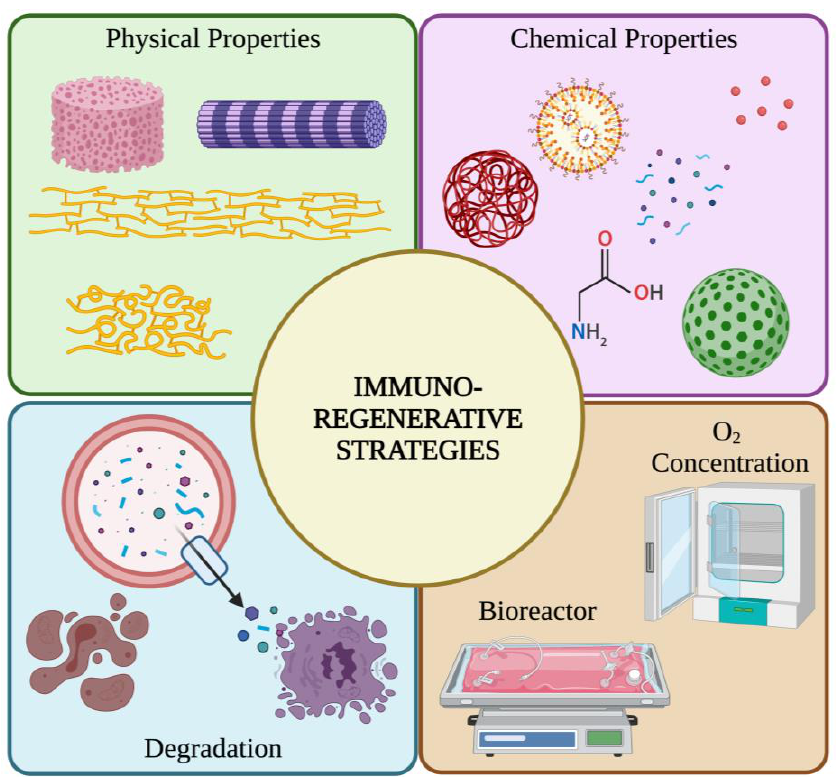
Figure 4. Immunoregenerative strategies applied in tendon TE to modulate the immune response of immune and stem cells.